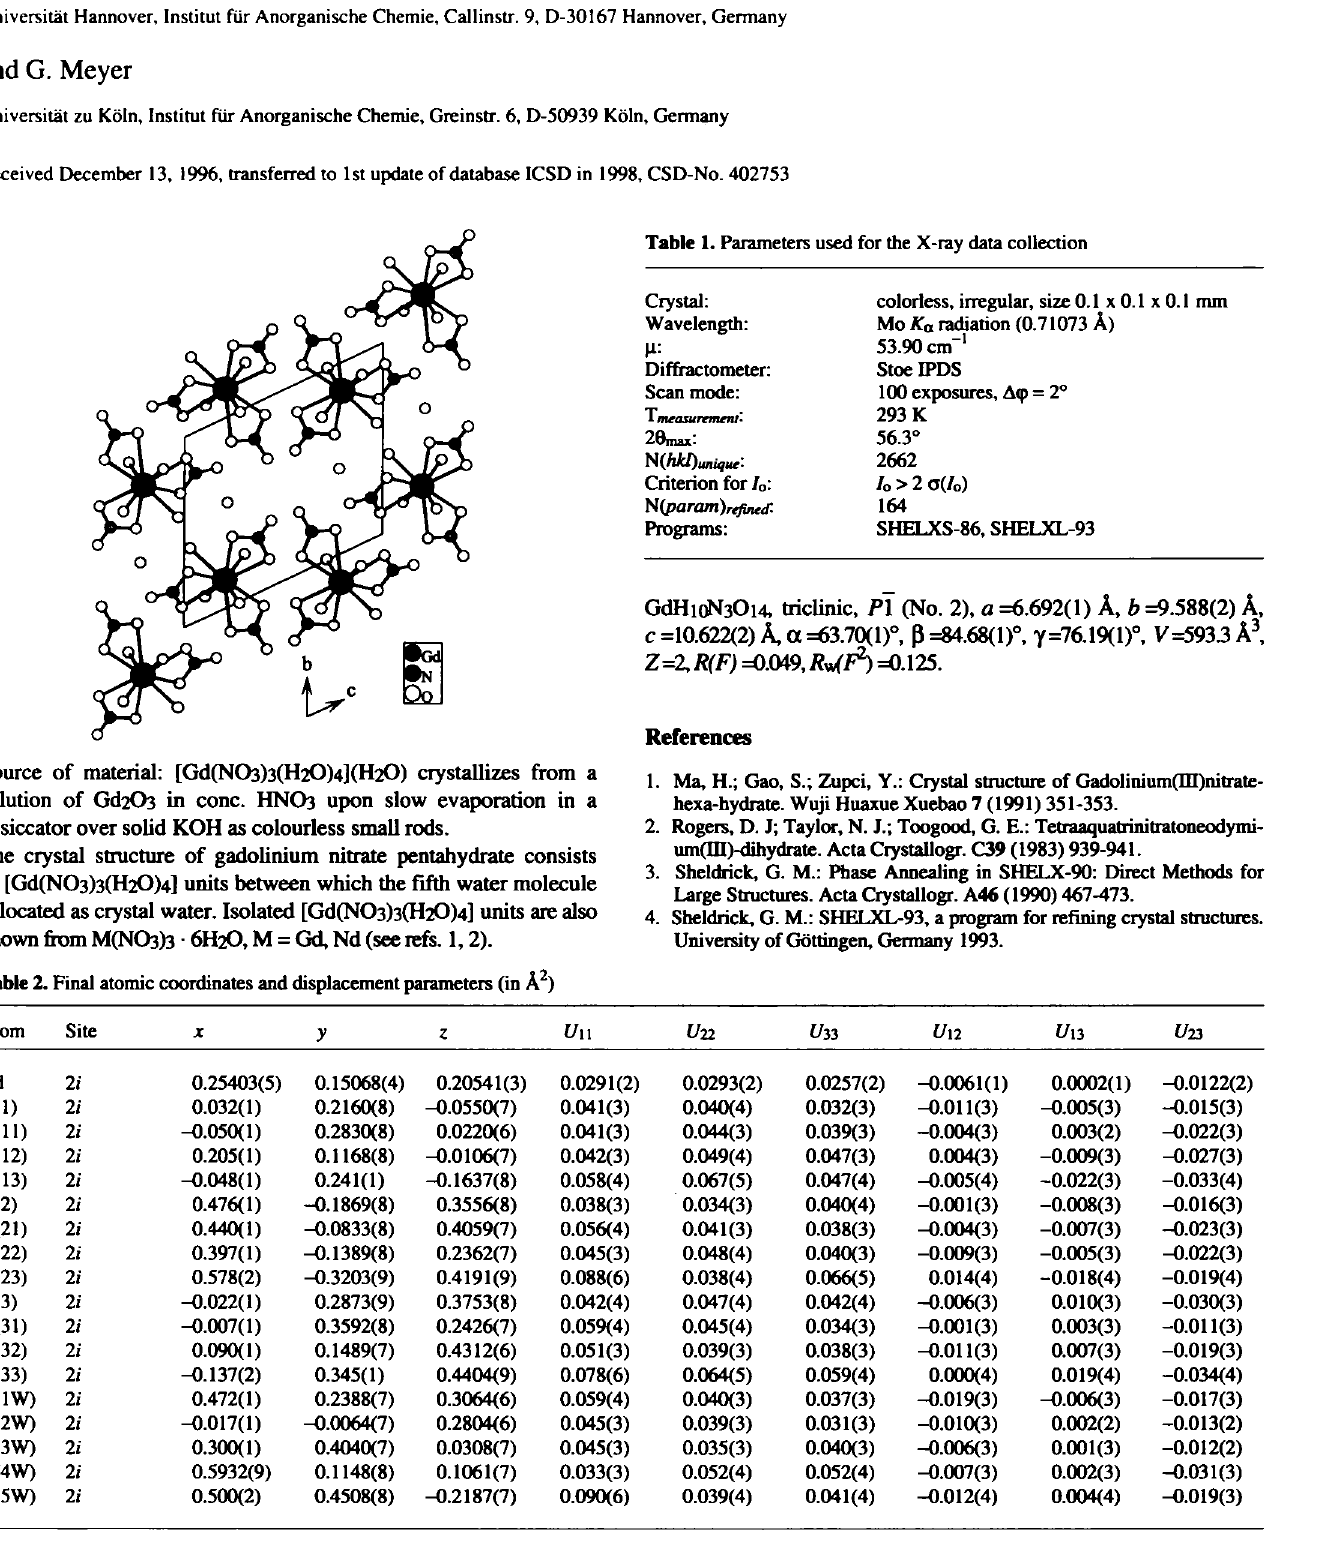
Table 1. Parameters used for the X-ray data collection Crystal: